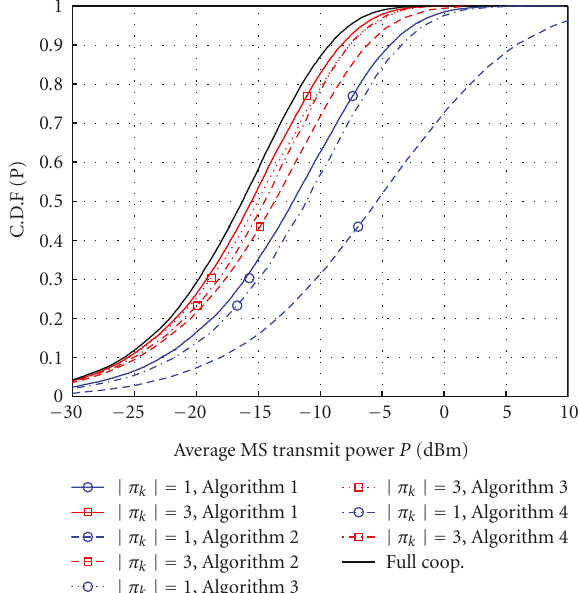
Figure 4: Comparison of CDFs of transmit power of di ff erent sizes of joint processing MBS with the SINR constraint of 0